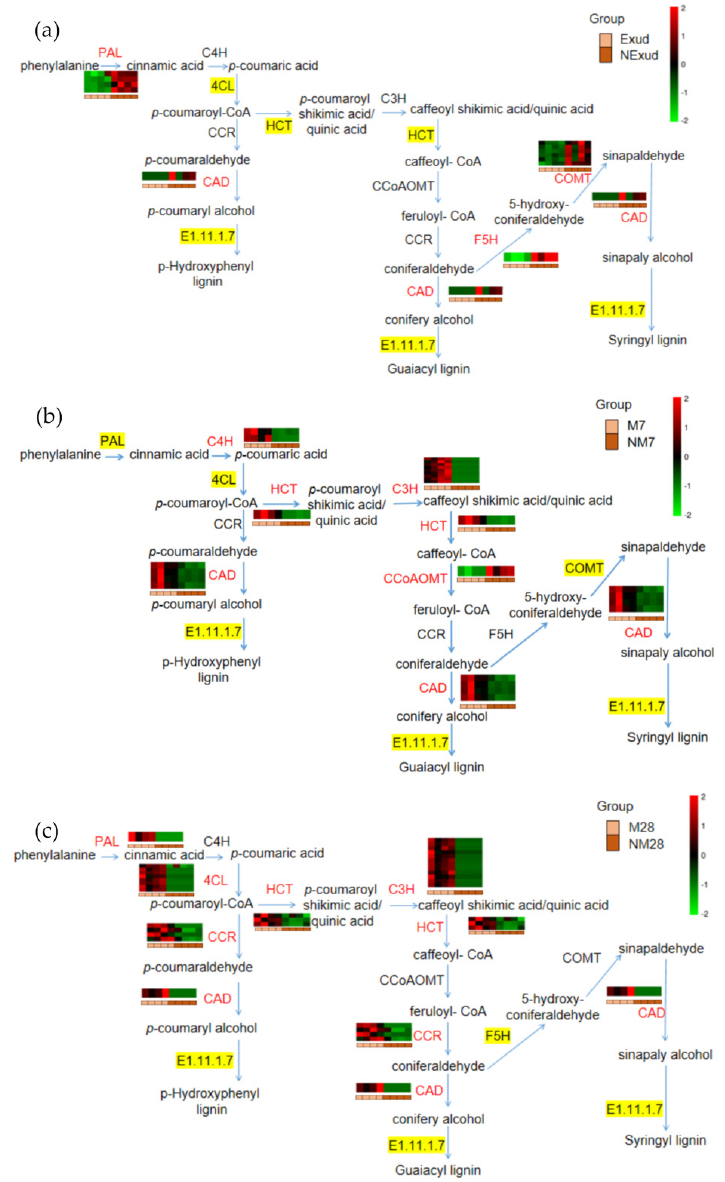
Figure 6. Phenylpropanoid biosynthesis pathway with heatmaps showing fold changes in the ex- pression of genes encoding key enzymes in this pathway. ( a ) Exud vs. NExud; ( b ) M7 vs. NM7; ( c ) M28 vs. NM28. Key enzymes encoded by DEGs that were annotated in metabolic pathways are shown in red. An enzyme highlighted in yellow indicates that both upregulated and downregulated genes encode the enzyme. An enzyme that is not highlighted in yellow indicates that no genes en- coding the enzyme were annotated. Enzymes: PAL, phenylalanine ammonia-lyase; C4H, cinnamate 4-hydroxylase; 4CL, 4-coumarate:CoA ligase; HCT, hydroxycinnamoyl-CoA shikimate/quinate transferase; C3H, coumarate 3-hydroxylase; CCoAOMT, caffeoyl-CoA- O -methyltransferase; CCR, cinnamoyl CoA reductase; F5H, ferulate 5-hydroxylase; COMT, caffeic acid O -methyltransferase; CAD, cinnamyl alcohol dehydrogenase. 3.4. Effect of Inhibiting HCT Activity on ECM Morphogenesis